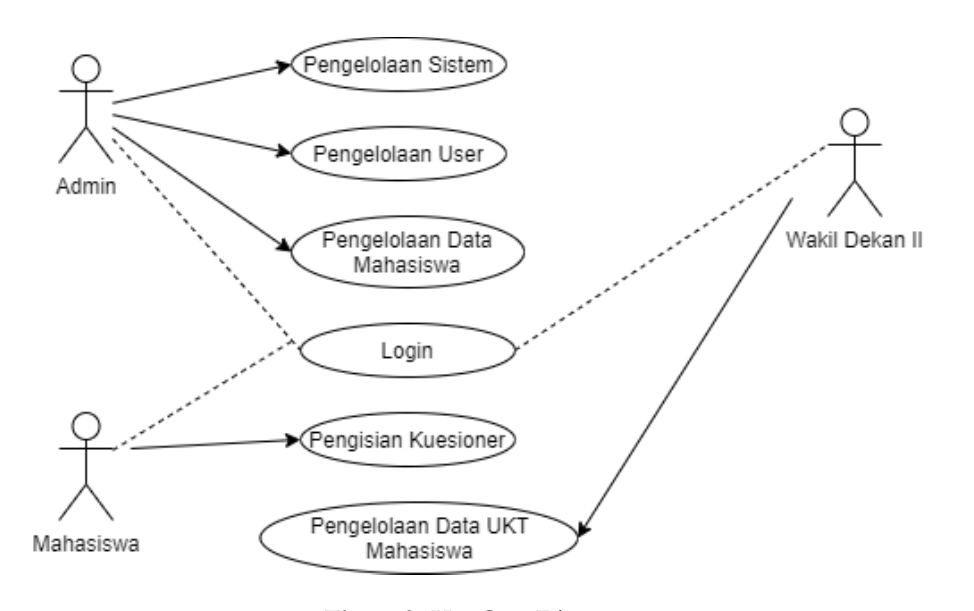
Figure 3. Use Case Diagram